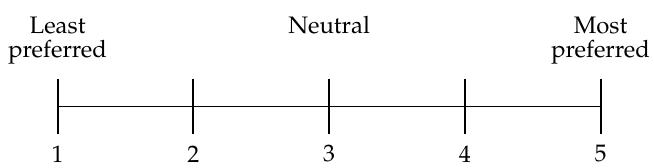
Figure 1. Example of a five-point scale, where the extreme scores of “1” and “5” represent least and most preferred, respectively, and the intermediate score of “3” represents a neutral